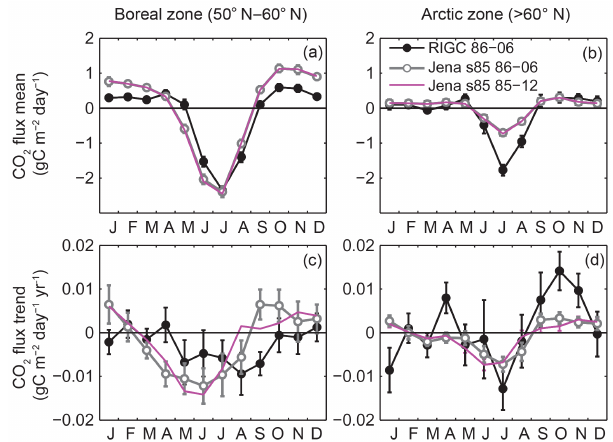
Figure 3. Mean monthly CO 2 fluxes for (a) arctic zone (>60 ◦ N) and (b) boreal zone (50–60 ◦ N). Black circles are the 1986–2006 means of the RIGC inversion. Grey squares are the Jena inversion over that same period. Magenta is the Jena inversion average over a longer time period (1985–2012). Differences are likely due to differences in atmospheric transport, including vertical mixing, be- tween the inversions. Linear monthly trends of (c) arctic zone and (d) boreal zone for the same inversions and time periods as in (a) and (b)